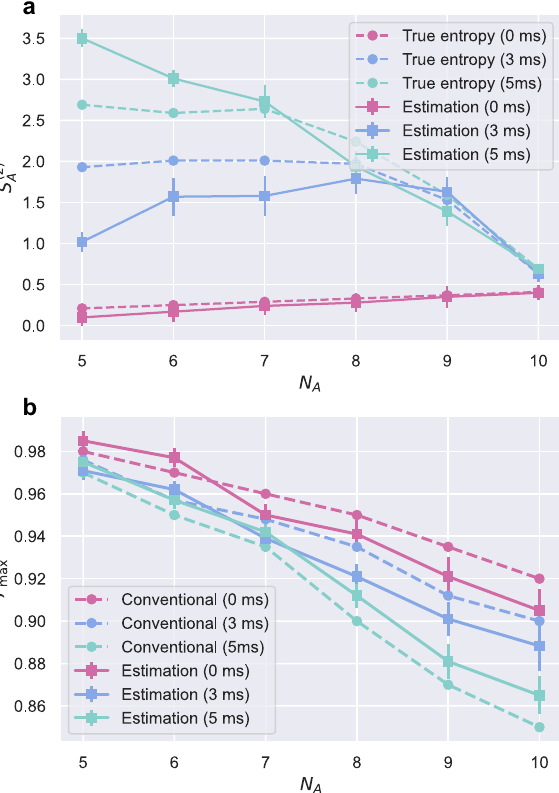
Fig. 5 The estimation performance of the MLCP model when evaluating independent measurements with t = 0, 3, 5 ms. a The entropy estimation compared with its theoretical value. b The maximum fi delity compared with conventional method 19 . The error bar denotes the standard variance over repeated